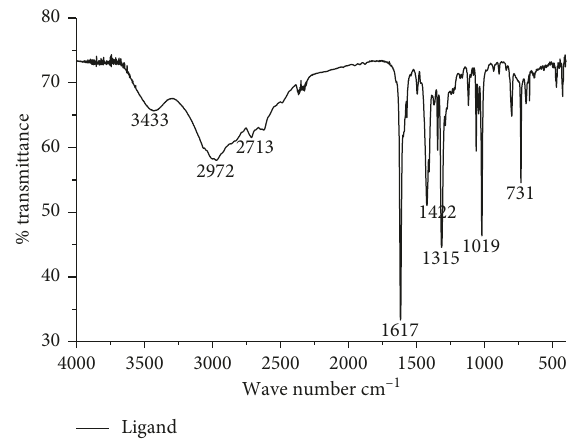
Figure 4: IR spectra of ligand 1,10-PDTU.